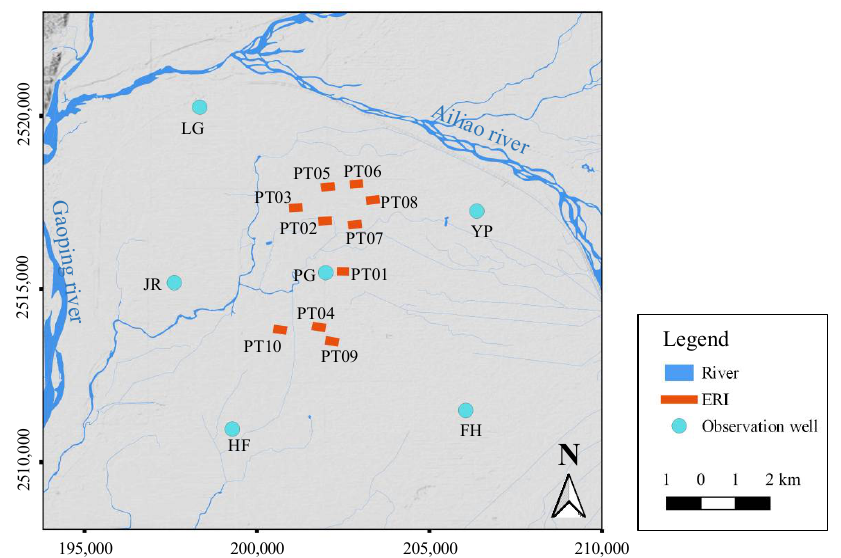
Figure 4. ERI survey location and groundwater observation wells. HF: Haifeng; JR: Jiuru; LG: Ligang; PG: Pengcuo; YP: Yanpu; FH: Fanhua.